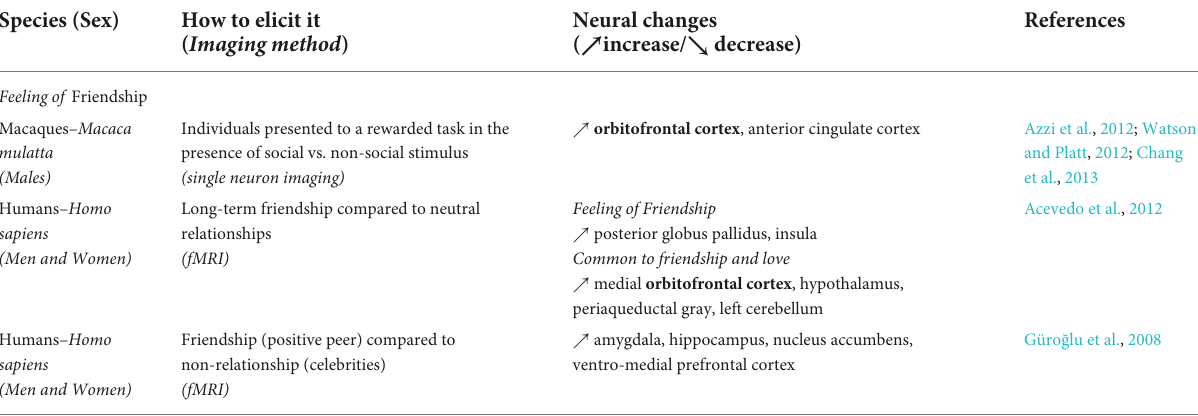
TABLE 3 Summary of the brain areas involved in the expression of the Feeling of friendship across species. Species